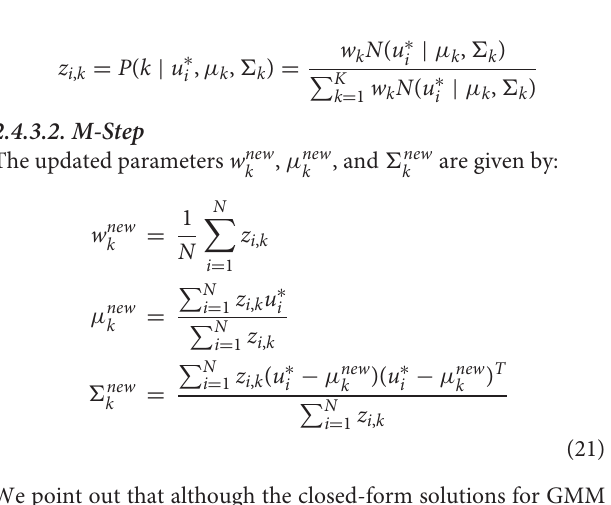
FIGURE 4 | Single models on HPP. (A) Contour of single Dirichlet model for 2-event realizations. (B) Center-outward rank given by the single Dirichlet model for 2-event realizations. (C,D) Same as (A,B) except for the Gaussian